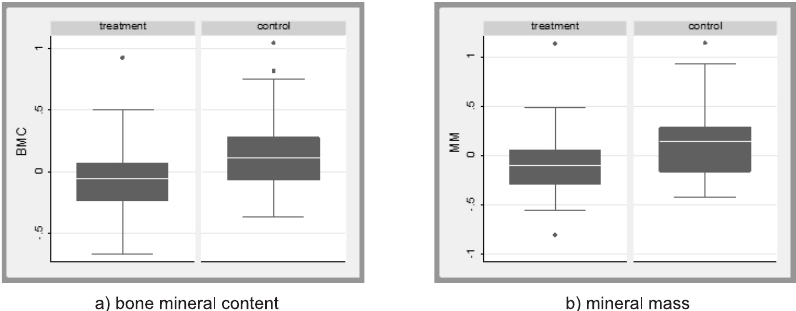
Figure 2. Box plots for two parameters between the treatment and control group